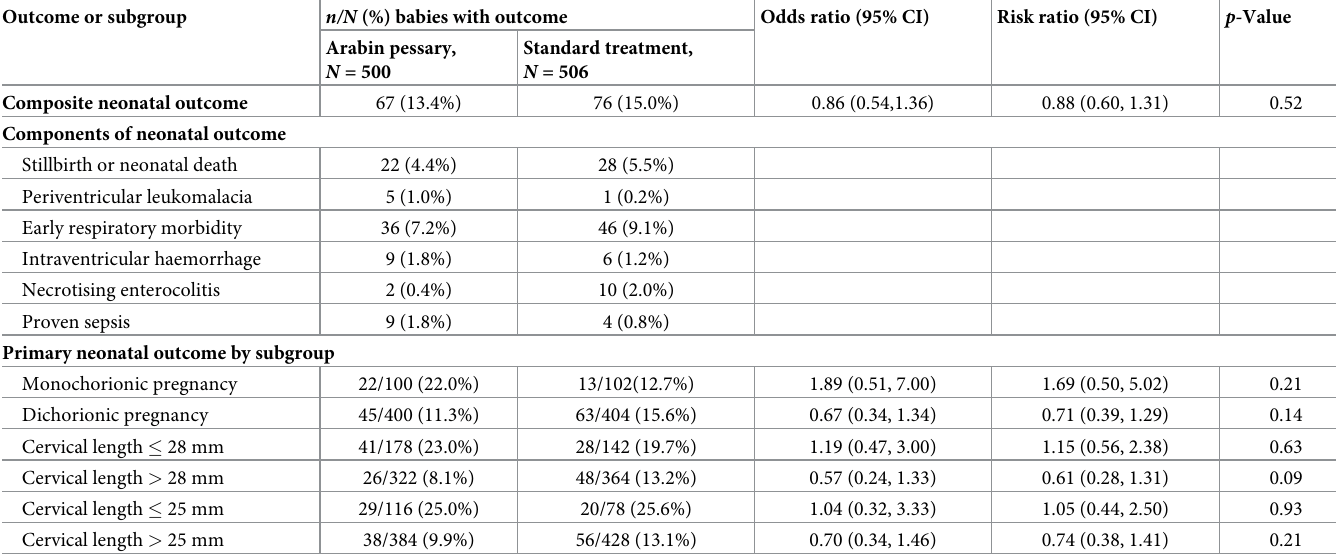
Table 3. Primary composite neonatal outcome, components, and key subgroup